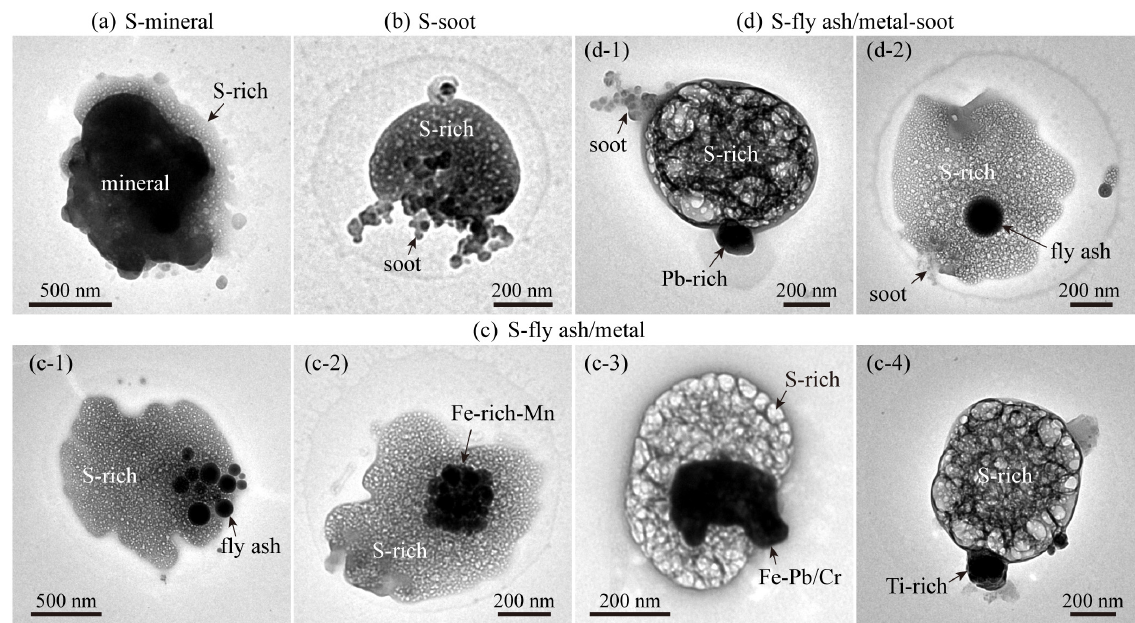
Figure 5. Typical TEM images showing mixing properties of multicomponents within individual cloud INT particles: (a) a mixture of S-rich and mineral particles; (b) a mixture of S-rich and soot particles; (c) a mixture of S-rich and fly ash/metal particles; and (d) a mixture of S-rich, soot, and fly ash/metal